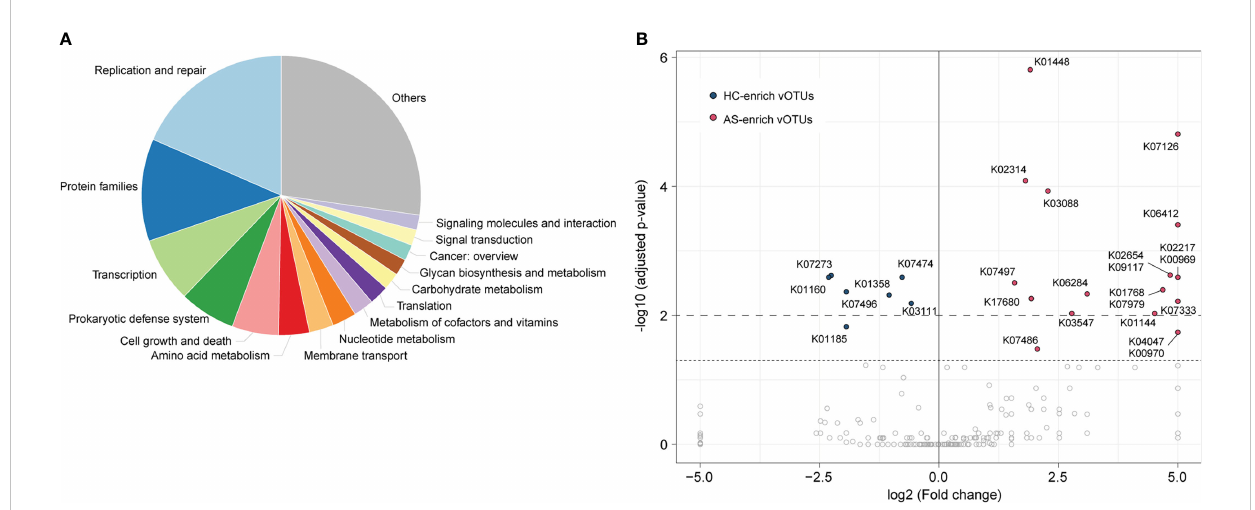
FIGURE 4 Comparison of functions between AS-enriched and HC-enriched vOTUs. (A) Composition of the functions of AS-associated vOTUs, as categorized at KEGG pathway level A. (B) Comparison of the occurrence rate of functions between AS-enriched and HC-enriched